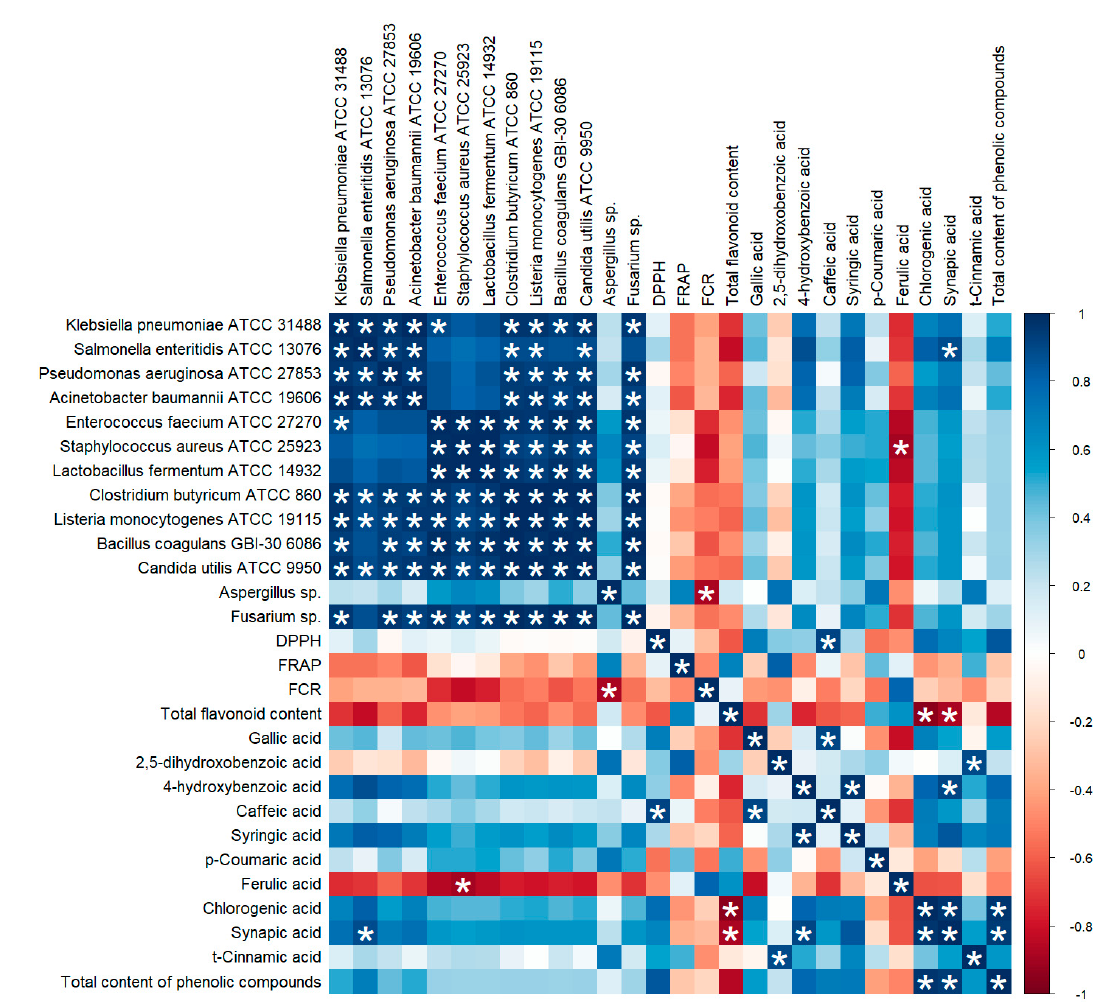
Figure 2. Correlation matrix. The intensity of the color is proportional to the correlation coefficient; white asterisk indicates a significantly statistical correlation ( p < 0.05).